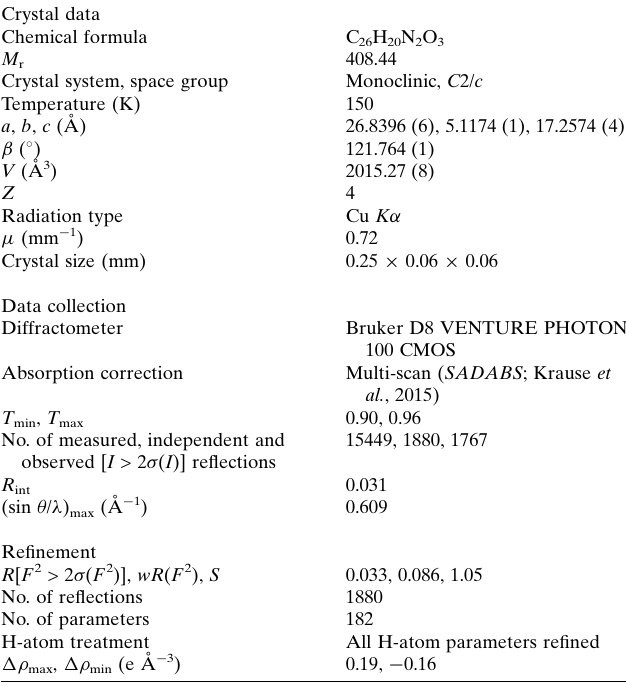
Table 3 Experimental details. Crystal data Chemical formula